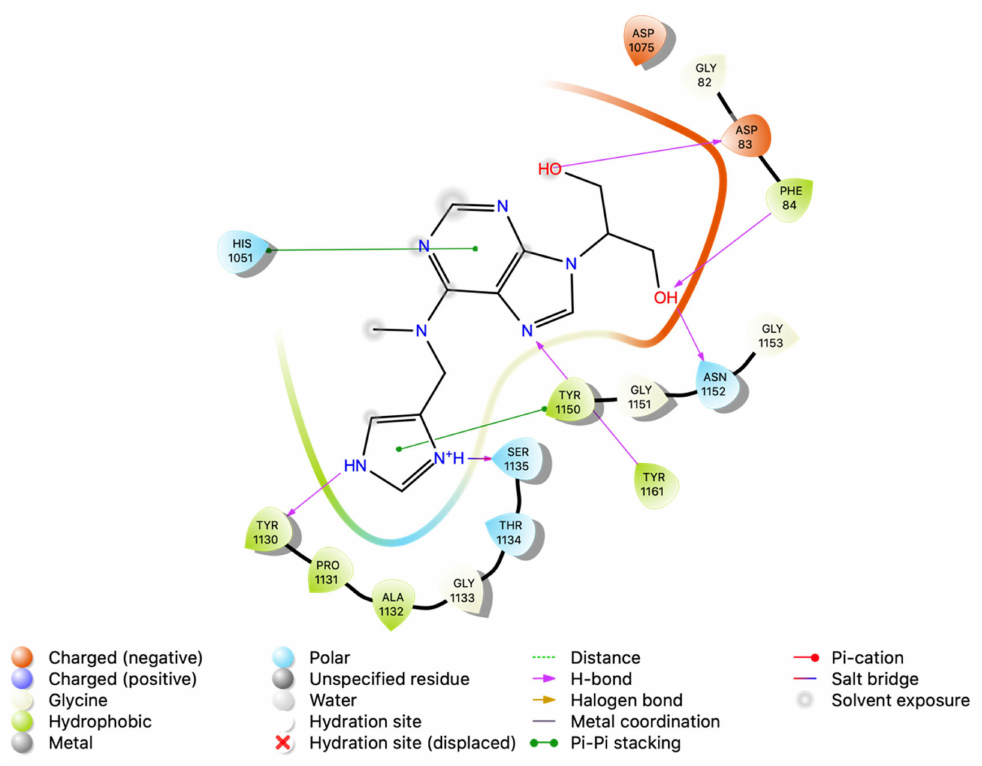
Figure 4. Interactions analysis of comp 3 with NS2B-NS3 protein of Zika